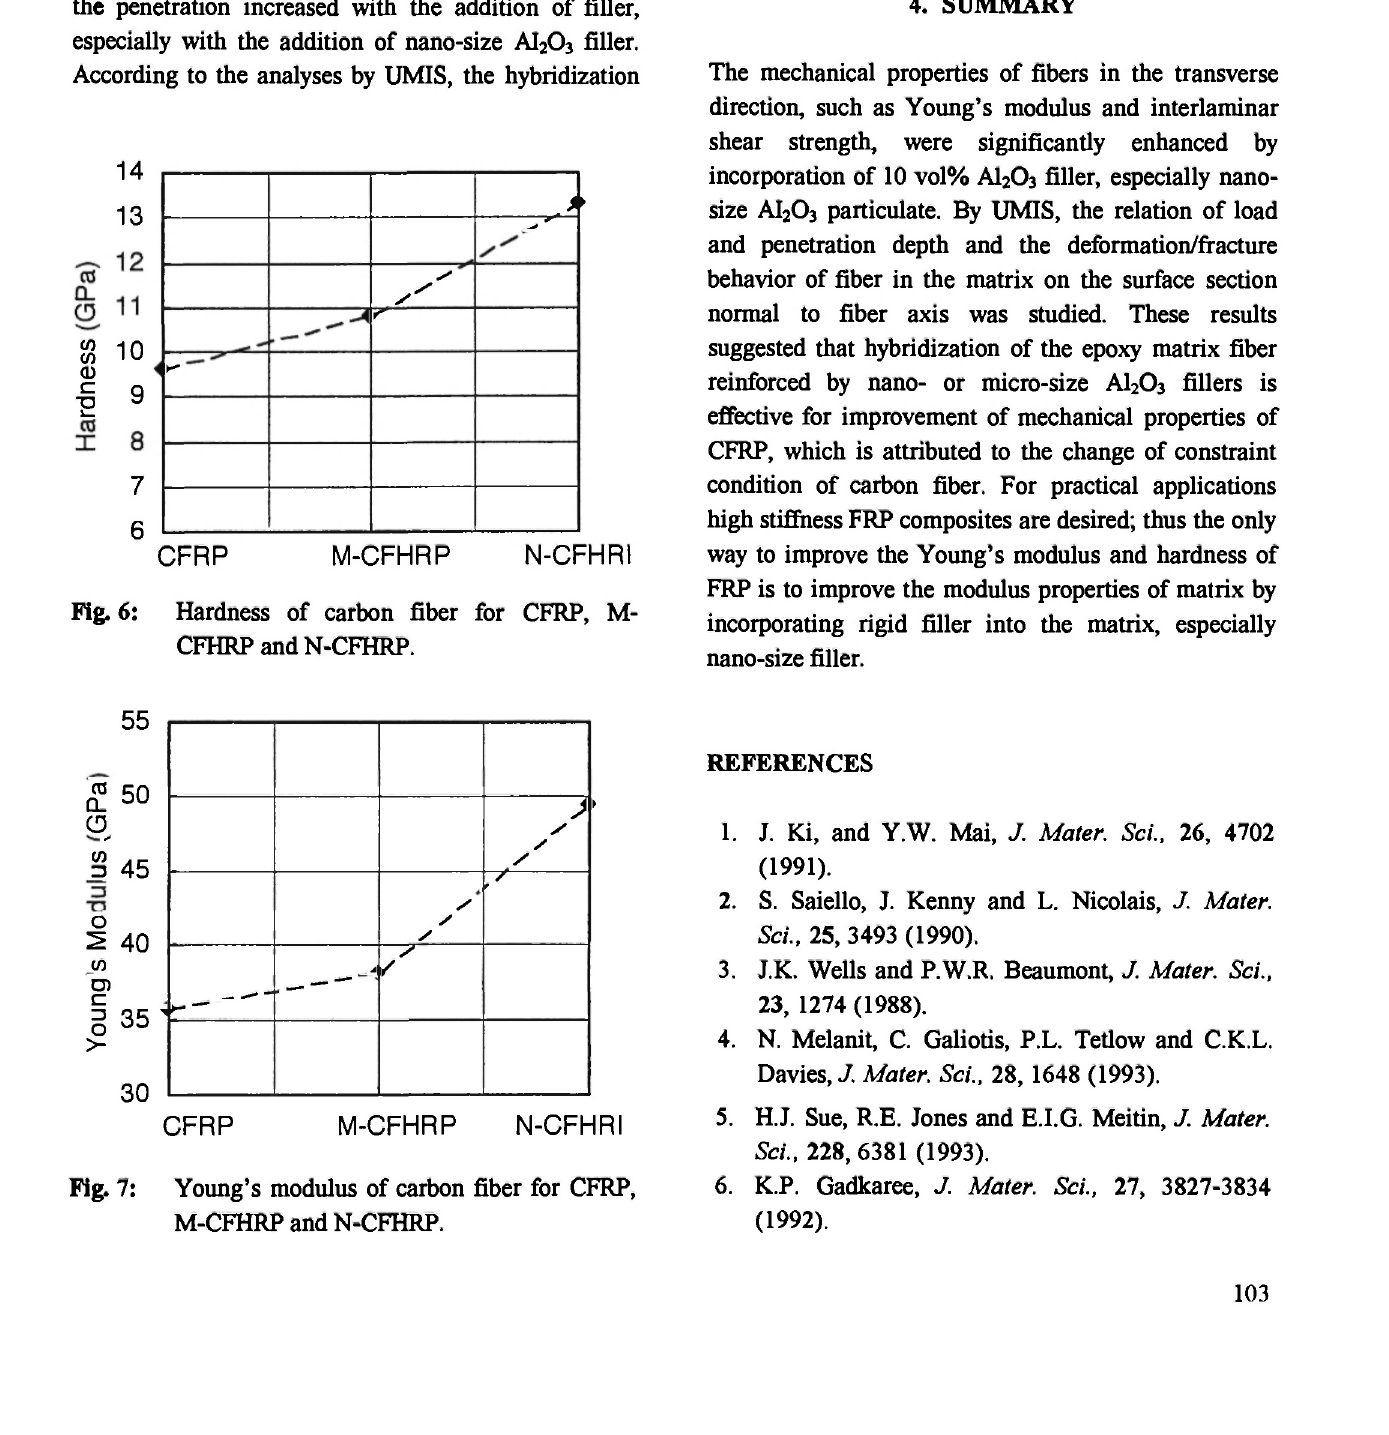
Fig. 6: Hardness of carbon fiber for CFRP, M- CFHRP and N-CFHRP.